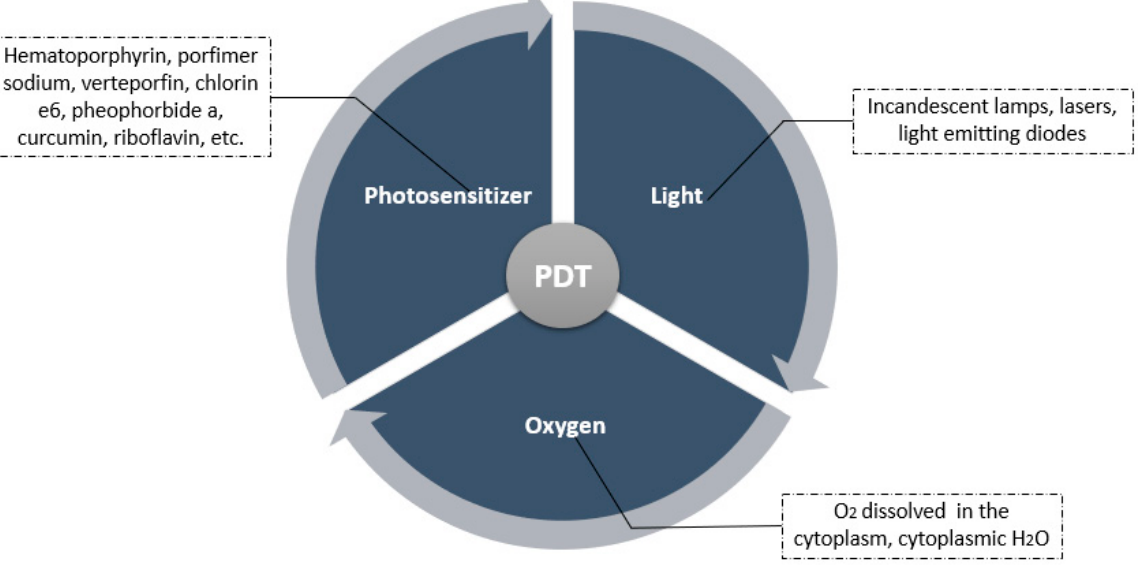
Figure 1. Main components of photodynamic therapy. Created based on literature references [12,18,26–28].